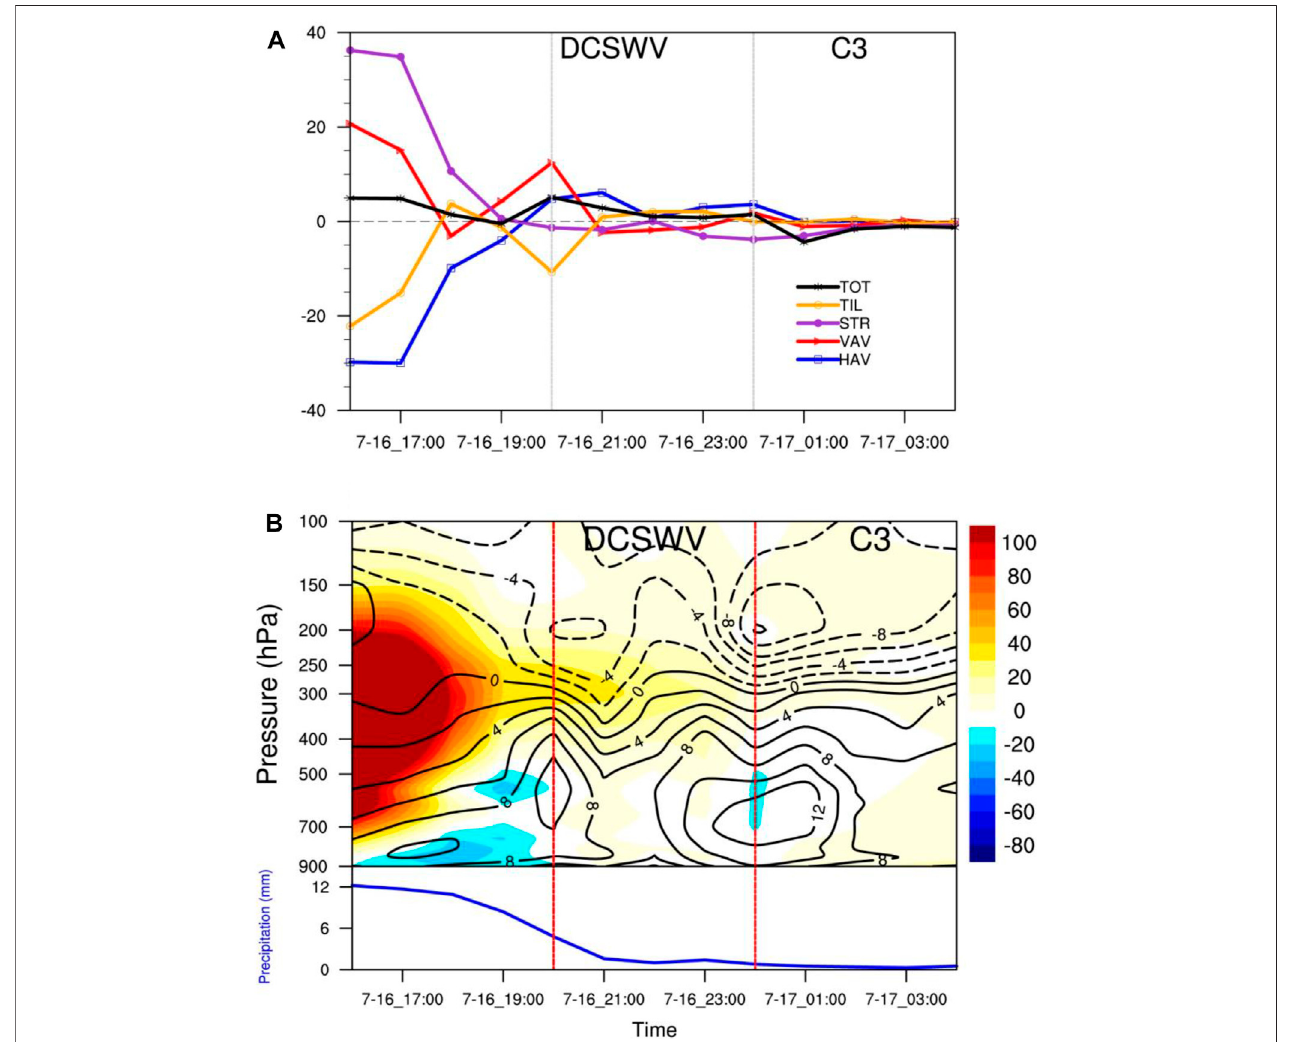
FIGURE 14 | (A) Regionally averaged vorticity budget terms (units: 10 − 9 s − 2 ) of SWVs and (B) time – pressure sections of apparent heat source Q1 (K day − 1 , shaded),relativevorticity(10 − 5 s − 1 ,blackcontours),andregionalmeanprecipitationwithinthekeyregion(mm,blueline)from16:00UTCJuly16to04:00UTCJuly17in the NOTER